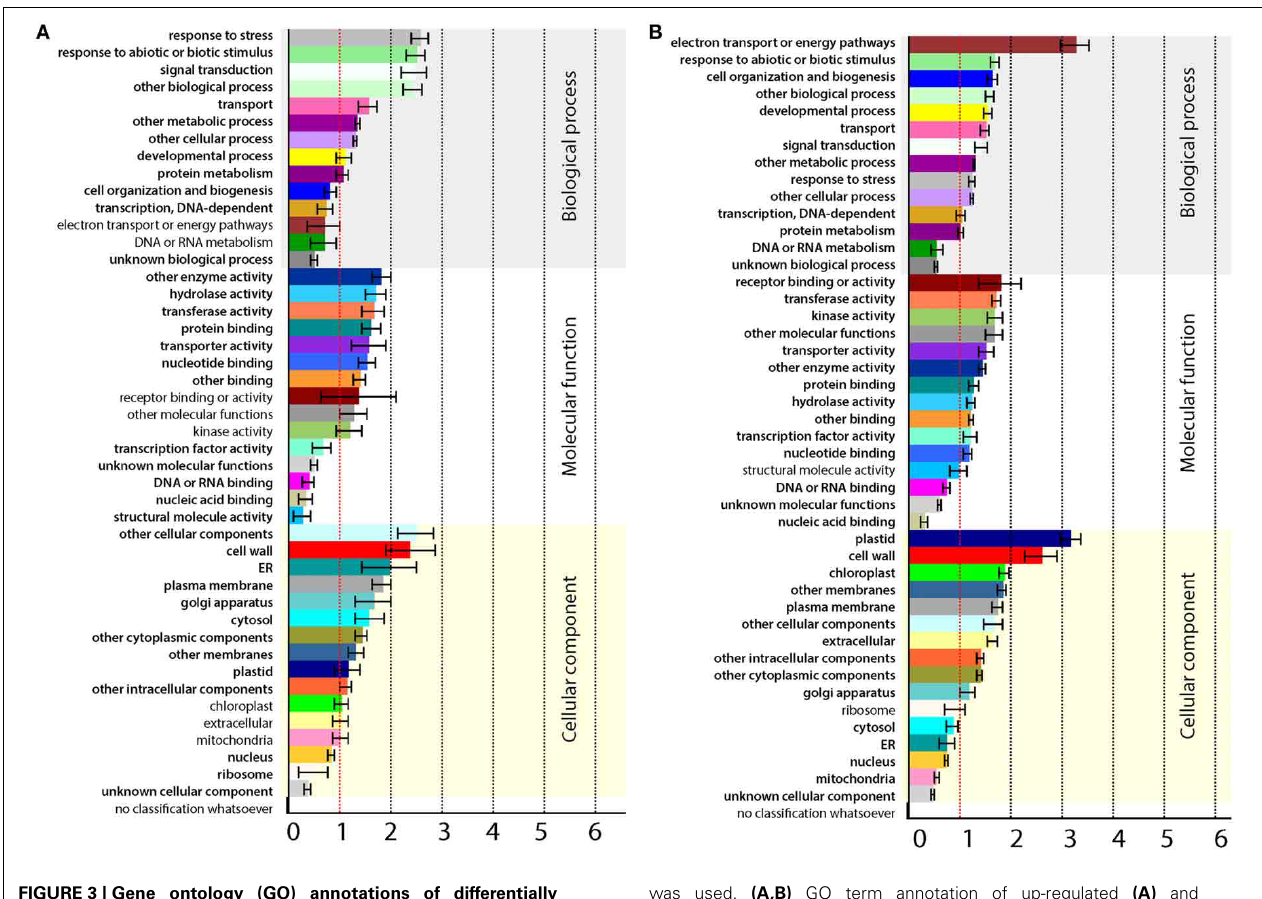
FIGURE 3 | Gene ontology (GO) annotations of differentially expressed genes (DEG). Classification SuperViewer tool at The Bio-Analytic Resource (BAR) for Plant Biology (http://bar.utoronto.ca)